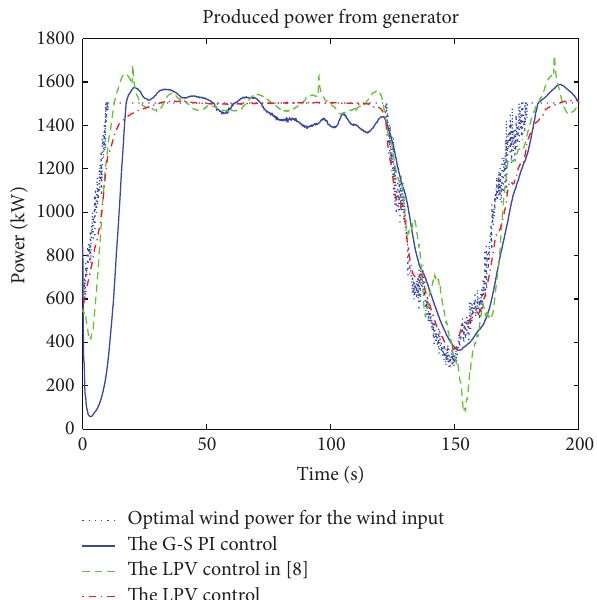
Table 2: Principal data of synchronous generator.